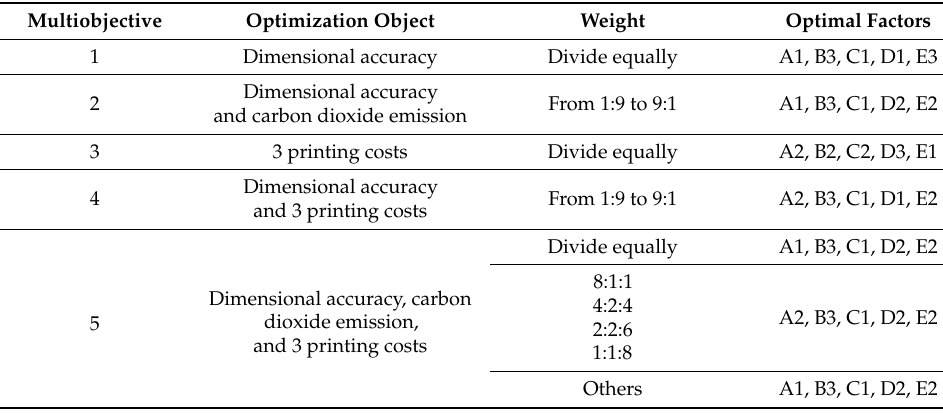
Figure 6. Factor contribution of all single objectives. Table 6. All multiobjective optimal